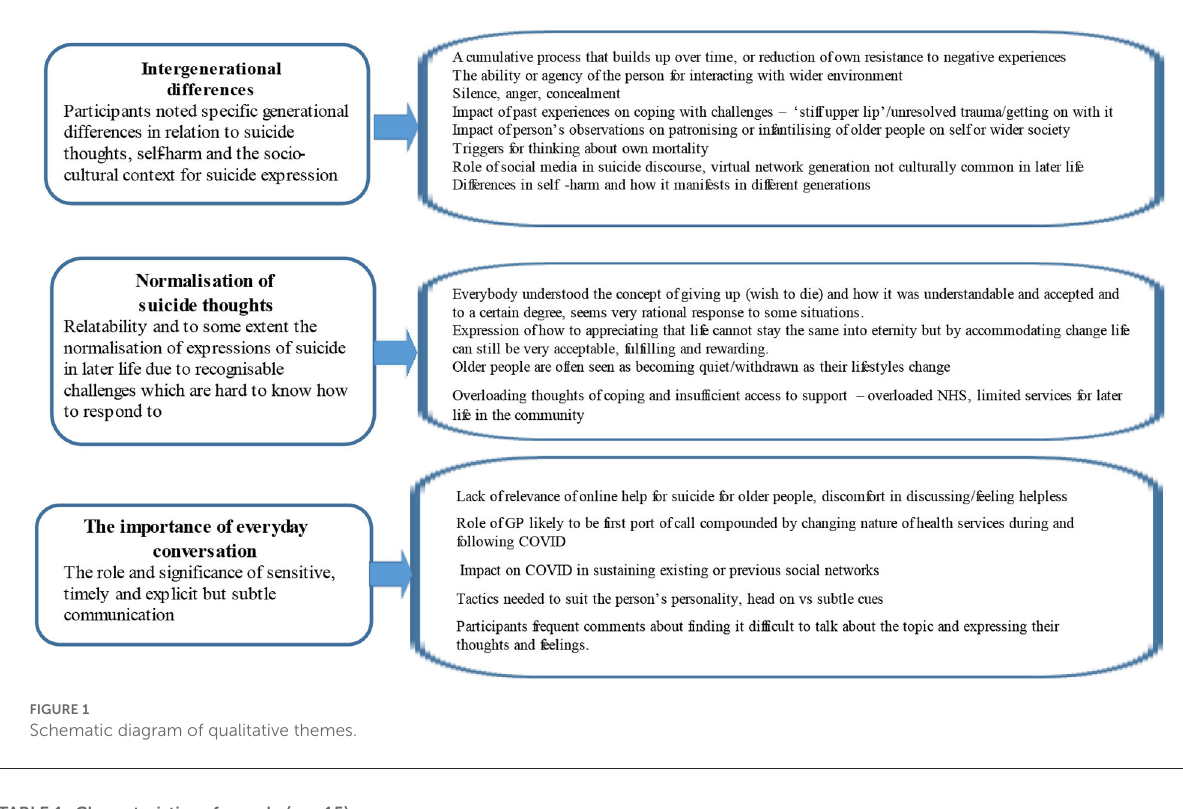
TABLE 1 Characteristics of sample ( n =